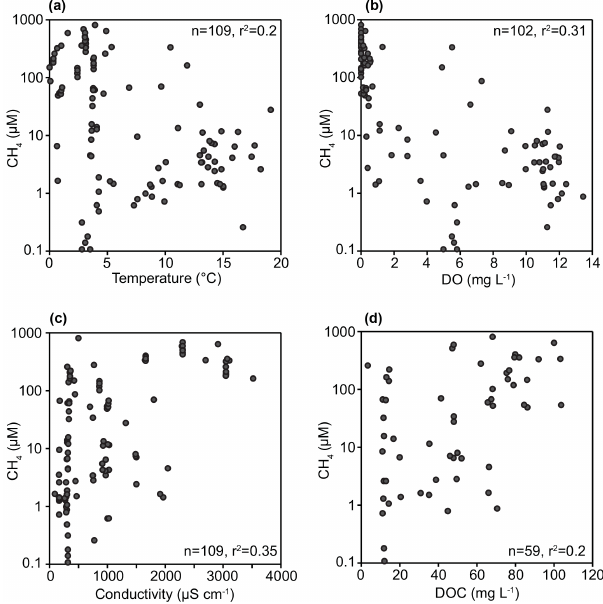
Figure 8. Relationships between dissolved CH 4 concentrations from 2012 to 2014 and (a) temperature, (b) DO, (c) conductivity, and (d)